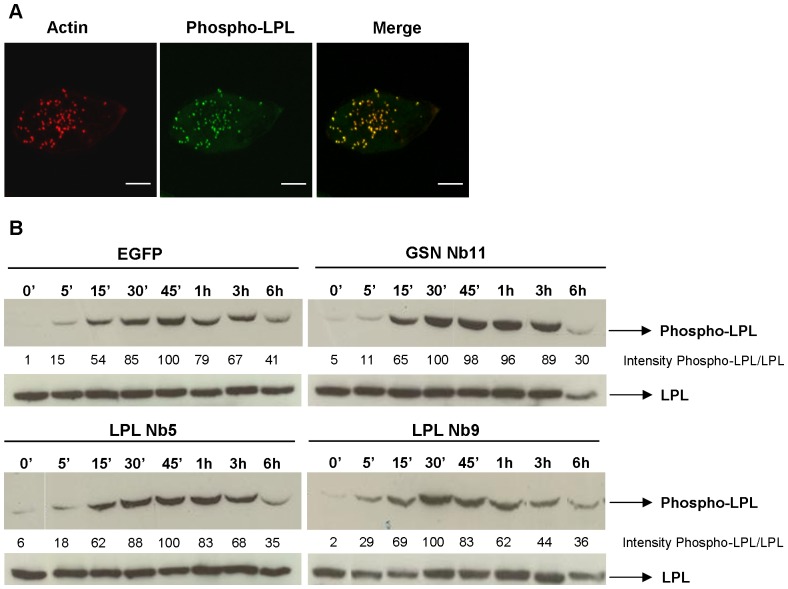
Ser5 phosporylated L-plastin is enriched in podosomes.(A) PMA differentiated THP-1 cells were stained for phospho-Ser5 L-plastin (alexa 488, green) and F-actin (phalloidin-alexa 594, red). Bar: 10 µm. (B) L-plastin phosphorylation is unaffected by LPL Nbs. THP-1 cells stably expressing EGFP, GSN Nb11, LPL Nb5 and LPL Nb9 were stimulated for different periods of time with PMA. The blots were stained for phospho-L-plastin and total L-plastin as a loading control. Data are representative of three independent experiments. Densitometry was used to determine band intensity in (B) and is expressed as phospho-LPL:LPL.